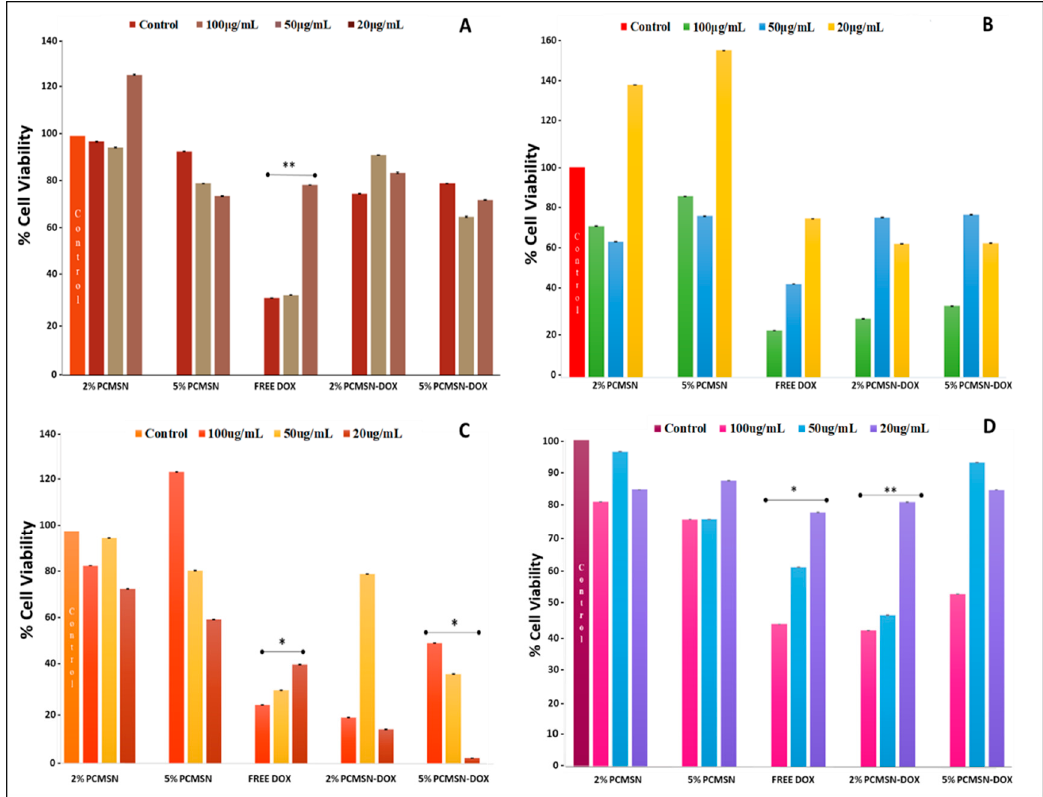
Figure 6. MTT cell viability assay of MSNs and DOX-loaded MSNs administered at various concentrations (20, 50 and 100 μ g/mL) in ( A ) HEK293, (B) Caco-2, ( C ) MCF-7 and ( D ) HeLa cells for 48 h. Data is represented as means ± SD ( n = 3). * p < 0.05, ** p < 0.01 were considered statistically significant. Table 4. IC 50 values of DOX-MSN treatments administered to tested cell lines (from Figure 6).